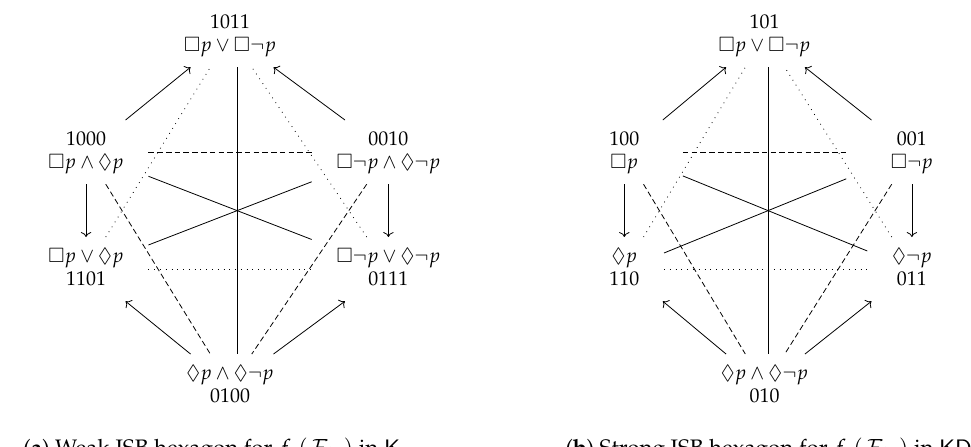
Figure 14. Aristotelian diagrams for f 3 ( F 1 a ) = { (cid:3) p ∧ ♦ p , ♦ p ∧ ♦ ¬ p , (cid:3) ¬ p ∧ ♦ ¬ p , (cid:3) p ∨ ♦ p , (cid:3) p